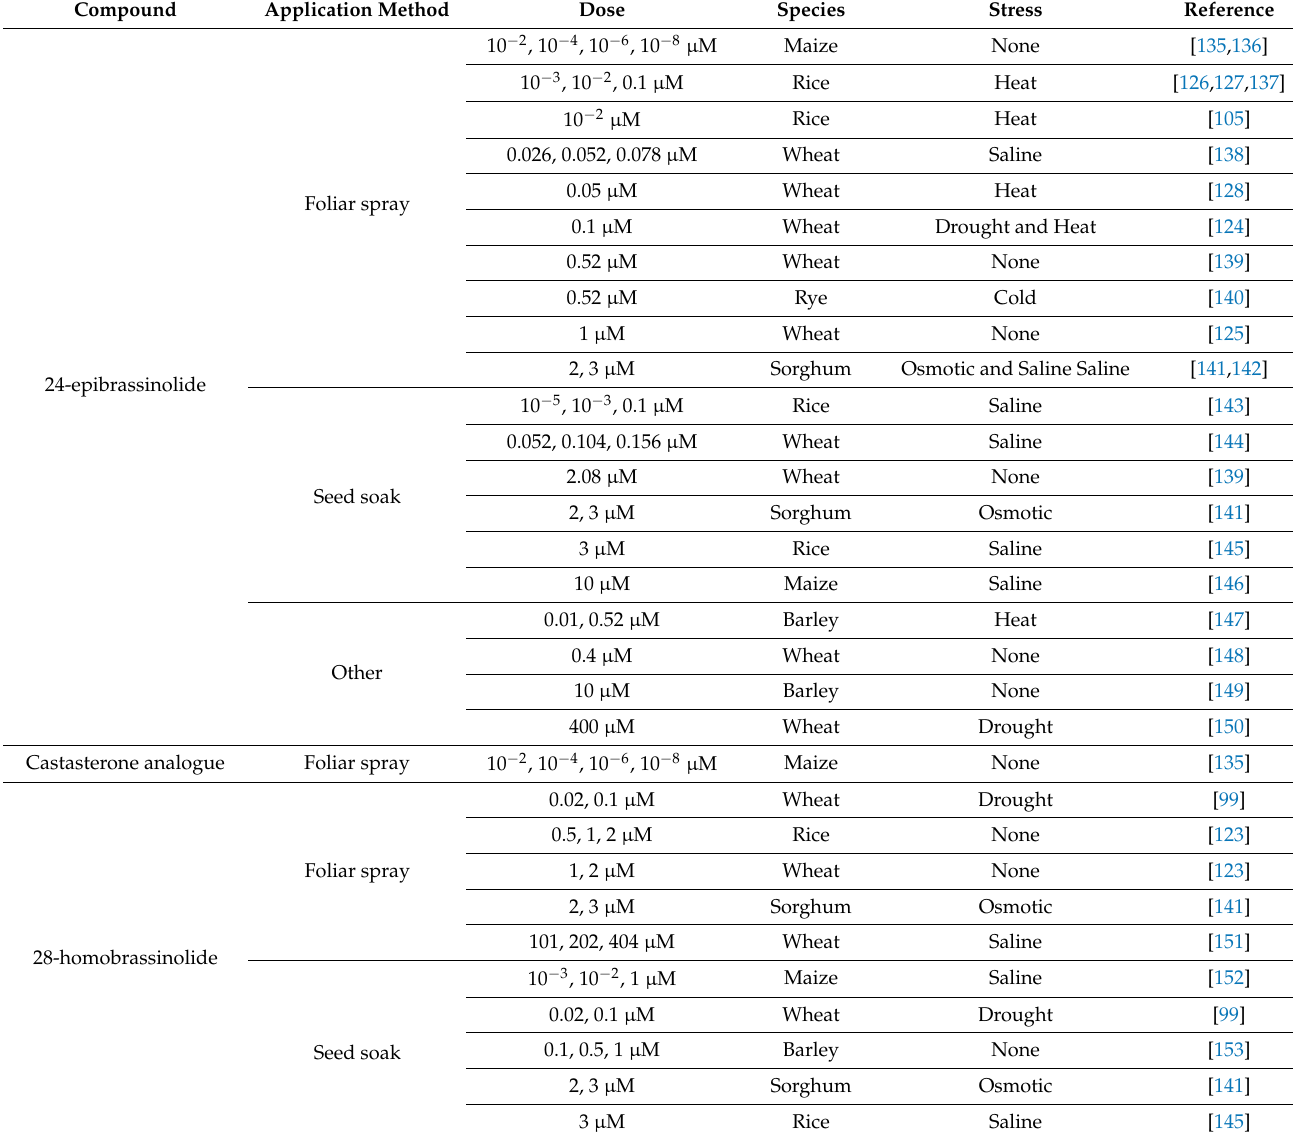
Table 1. Positive impacts of BR in cereals under optimal and stressed